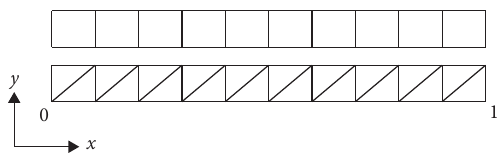
Figure 3: Discretization of one-dimensional seepage.